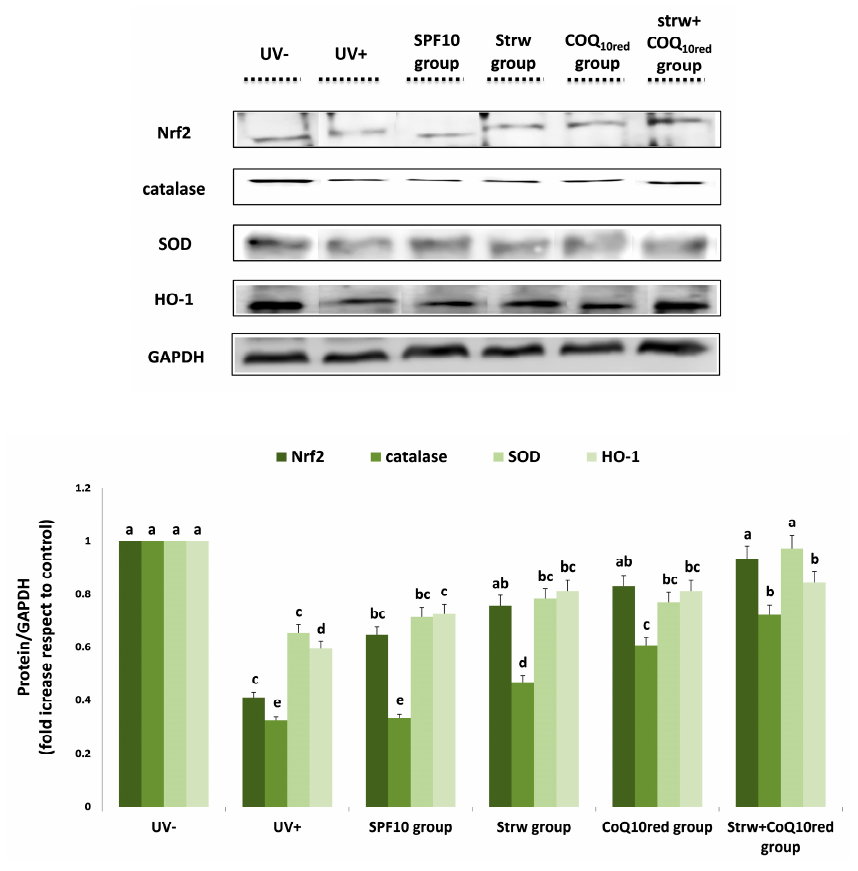
Figure 8. Levels of proteins related to antioxidant response (Nrf2, catalase, SOD, HO-1) in human dermal fibroblast (HDF) cells irradiated with ultraviolet A (UVA, 275 kJ/m 2 ) radiation (UV+) or not irradiated (UV − ), after 1 h of exposure. HDF were screened with different formulations as explained in the text. Data are expressed as mean values ± standard deviation (SD). Columns belonging to the same set of data with different superscript letters are significantly different ( p ˂ 0.05).